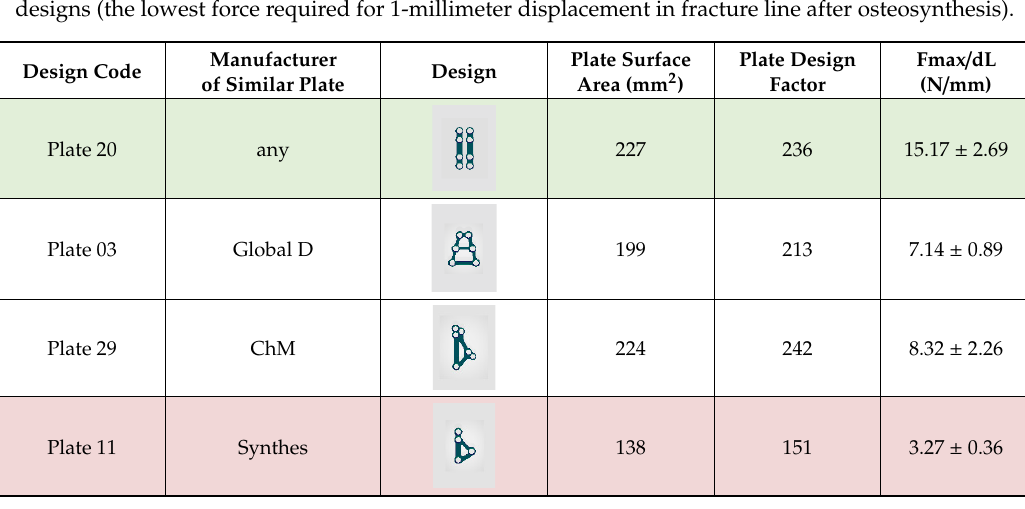
Figure 1. 5 samples of polyurethane mandibles with broken plates number 20 and 1 sample of mandible on testing plate in the testing machine. Table 1. Tested designs of plates dedicated for osteosynthesis of basal condylar fractures of the mandible. Green cells indicate the best mechanical designs (the highest force is required for 1-millimeter displacement in fracture line after osteosynthesis, F max / dL). Red cells indicate the worst mechanical designs (the lowest force required for 1-millimeter displacement in fracture line after